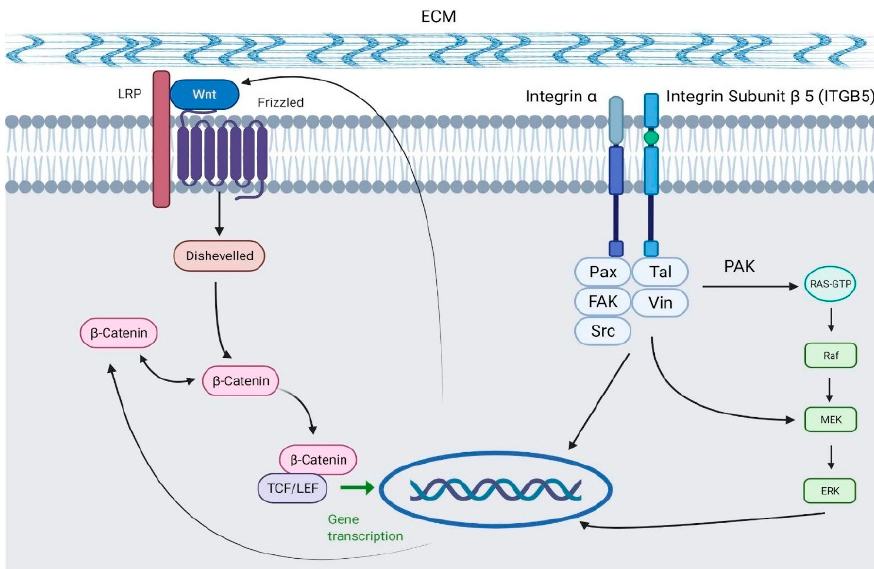
Figure 6. Diagram displaying the role of both ITGB5 and WNT in the transcription of genes to promote proliferation and differentiation [15] (Created with BioRender.com).